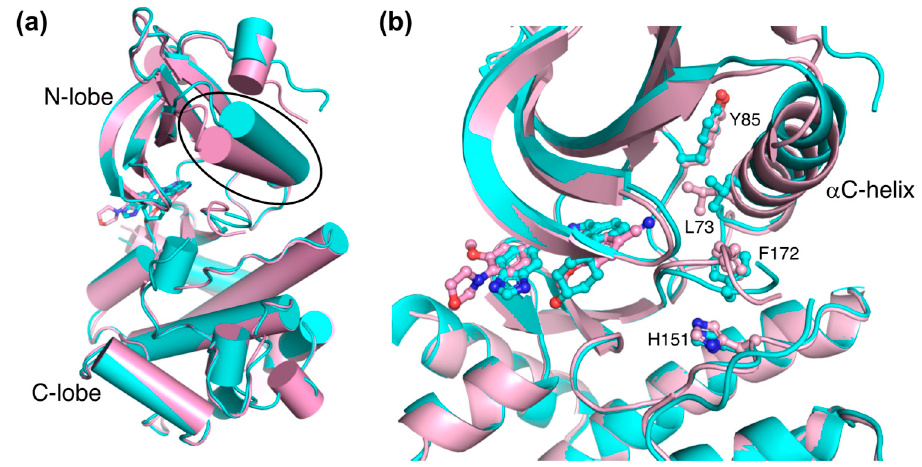
Figure 5. Comparison of the structures of NCB-0846-bound TNIK (cyan) (PDB ID: 5D7A) and phenylaminopyridine analog-bound TNIK (pink) (PDB ID: 5AX9). ( a ) Overall structure of the kinase domain. The different positions of the α C-helix are indicated by the oval. Bound inhibitors are shown in stick models. ( b ) Close-up view of bound inhibitors and hydrophobic R-spine residues (shown in ball-and-stick models).